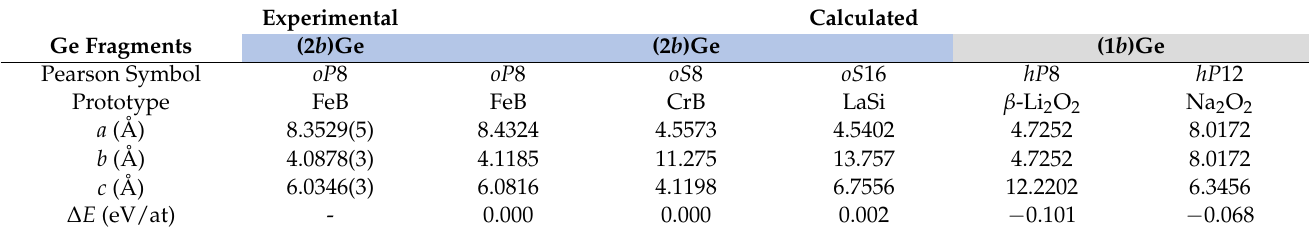
Table 7. Experimental and calculated unit cell parameters and total energy differences ( ∆ E ) for different CeGe polymorphs, simulated to crystallize with the FeB, CrB, LaSi, β -Li 2 O 2 , and Na 2 O 2 structure types. The ∆ E values are calculated with respect to the oP 8–FeB structure, experimentally found to be the most stable one: E (FeB)– E (CrB); E (FeB)– E (LaSi); E (FeB)– E ( β -Li 2 O 2 ); E (FeB)– E (Na 2 O 2 ).